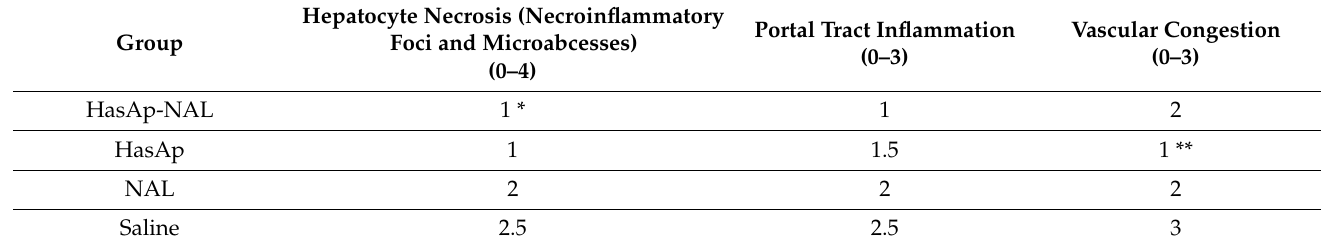
Table 3. Median values of histopathology scores of livers isolated from immunized and non- immunized mice.